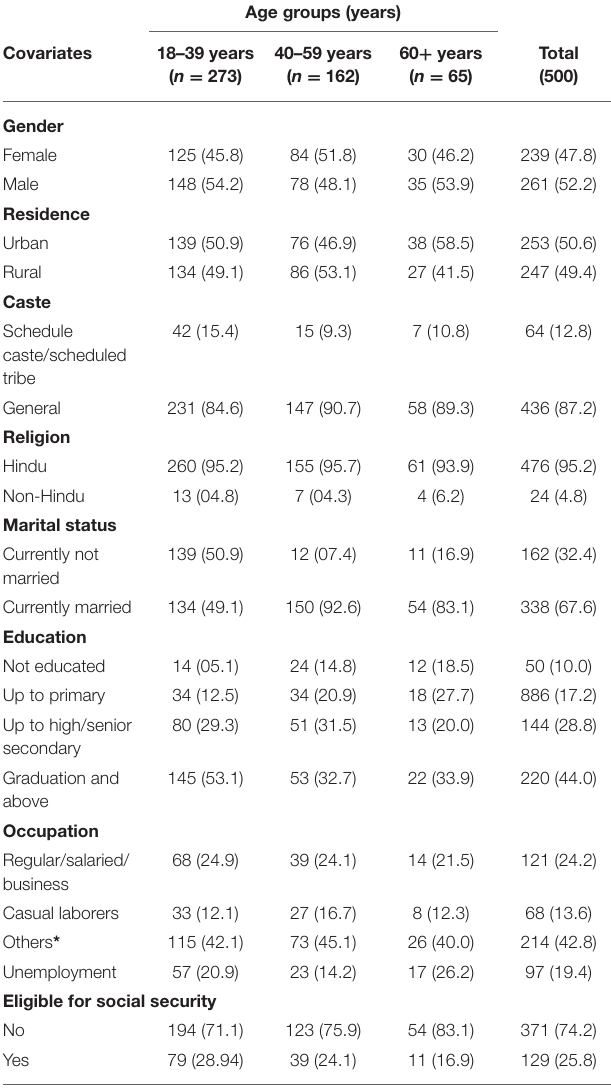
TABLE 1 | Characteristic of study participants enrolled in the study by age